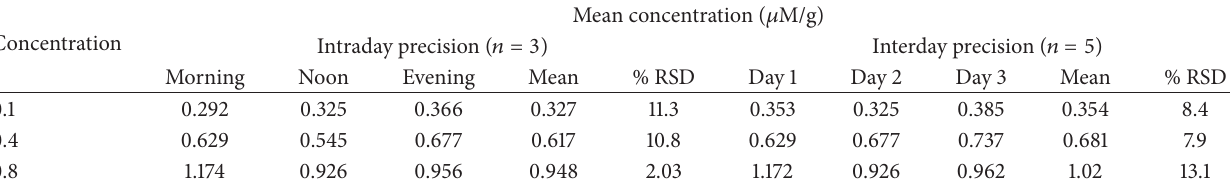
Figure 1: Typical reaction mechanism of malondialdehyde (MDA) and thiobarbituric acid (TBA) from the fried fast foods. The reaction was carried out at 95 ∘ C in water bath for 60 minutes. The pink colour complex is measured spectrophotometrically at 532 nm. Table 1: Intraday and interday precision of the spectrophotometric TBARS method.